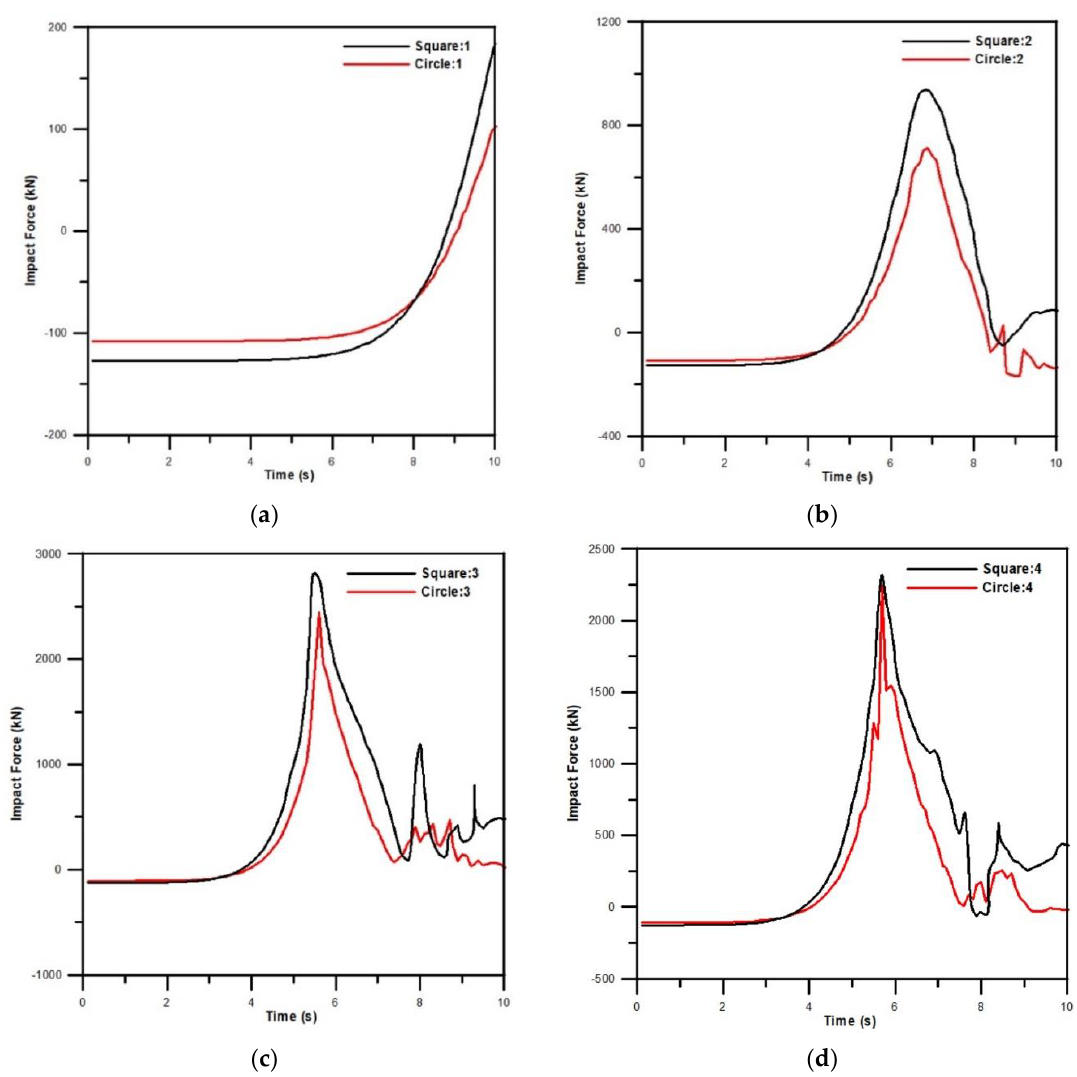
Figure 15. Time variation of the impact force on the individual square and cylinder where the slope bed is equal to 0.02 at the downstream for four cylinders ( a )cylinder 1; ( b )cylinder 2; ( c )cylinder 3; ( d )cylinder 4.